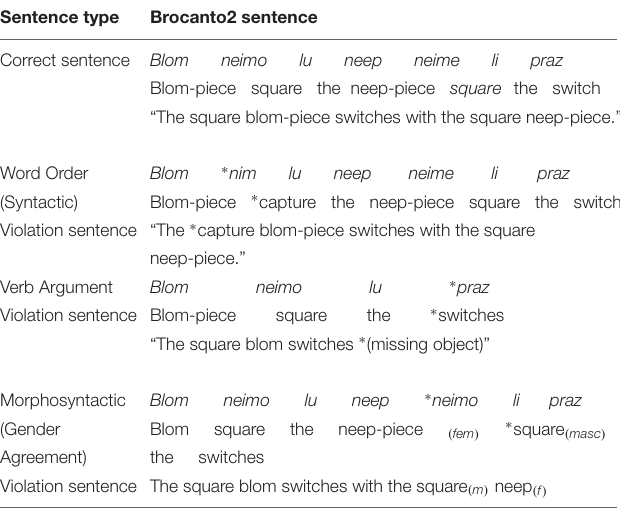
TABLE 3 | Example correct Brocanto2 sentences and violations